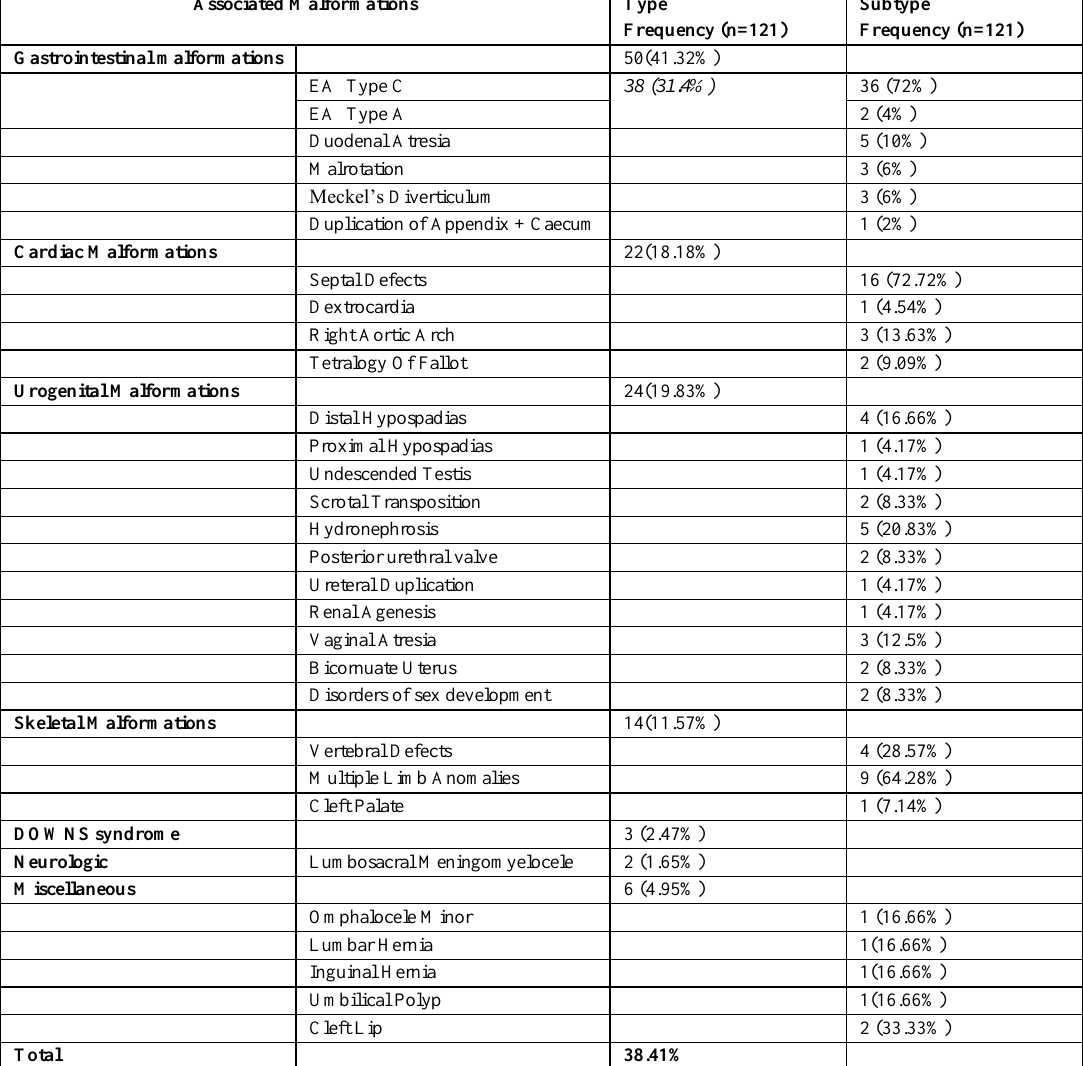
Table 3: Summary of associated malformations in the present study Associated